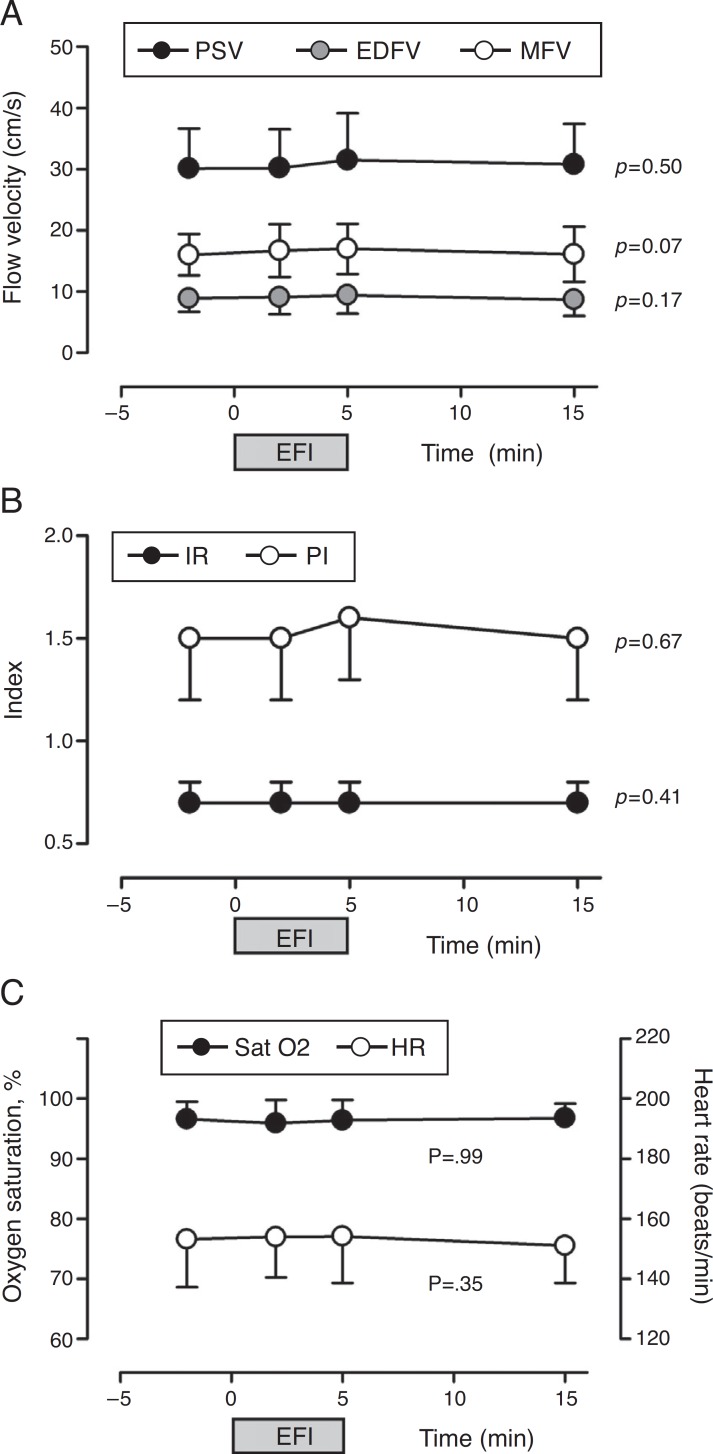
Influence of physiotherapy on cerebral blood flow velocity (A), resistance and pulsatility indexes (B) and oxygen saturation and heart rate (C) of premature newborns (n=40). PSV, peak systolic flow velocity; MFV, mean flow velocity; EDFV, end-diastolic flow velocity; PI, pulsatility index; IR, index of resistance; SatO2, peripheral oxygen saturation; HR, heart rate; EFI, expiratory flow increase technique.